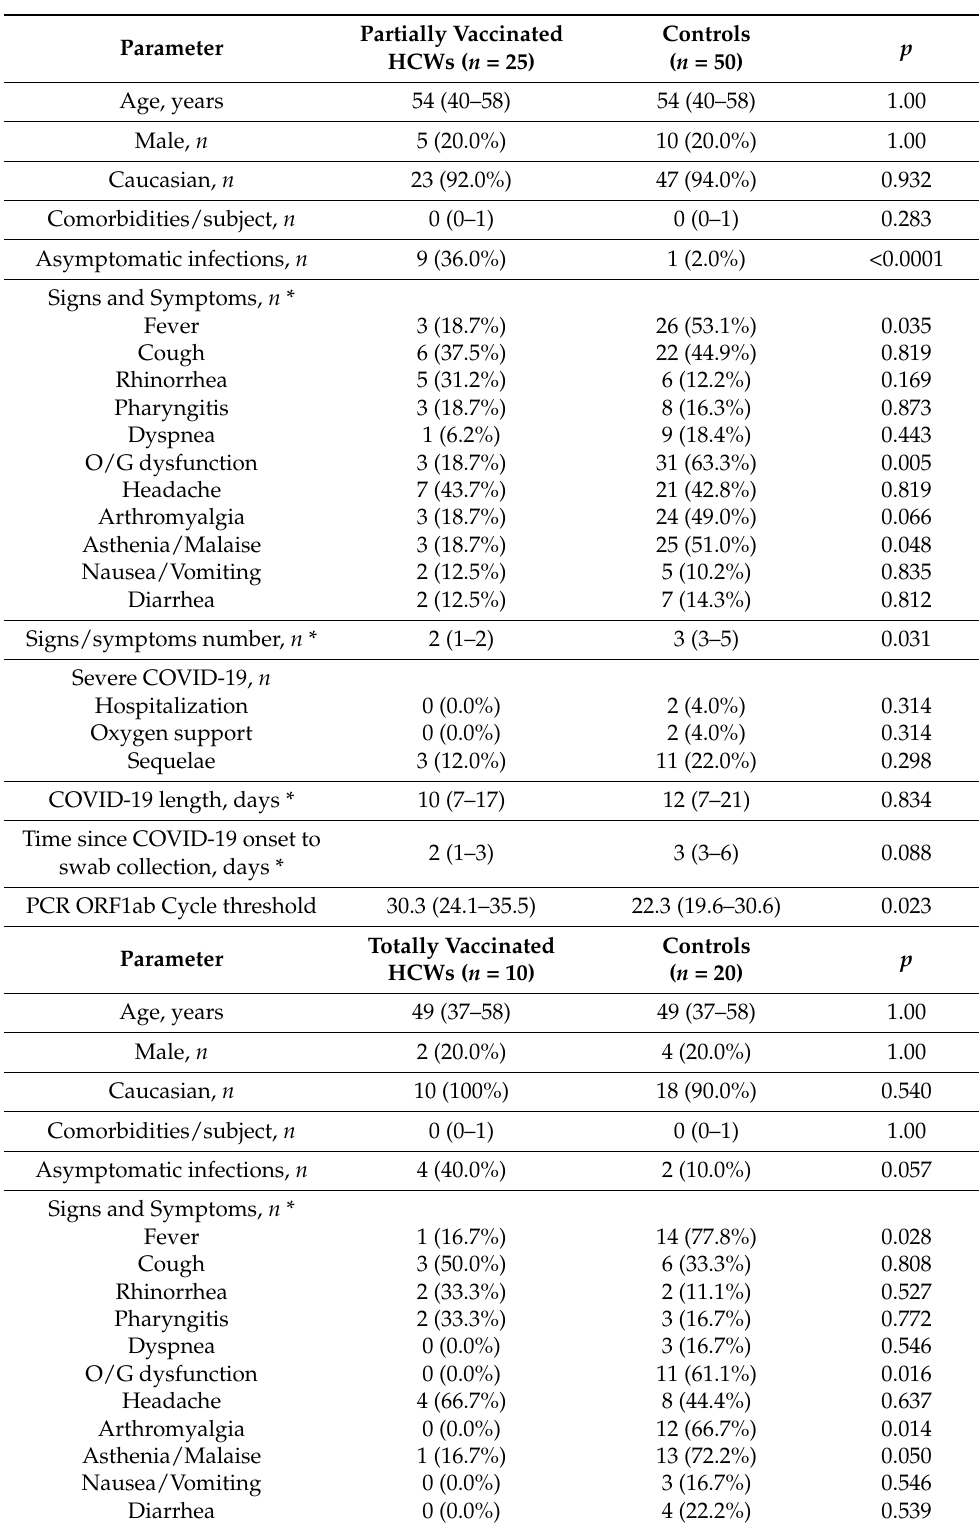
Table 1. Comparison of demographic, clinical, and virological features of partially and totally vaccinated SARS-CoV-2-positive healthcare workers and corresponding age- and sex-matched un- vaccinated